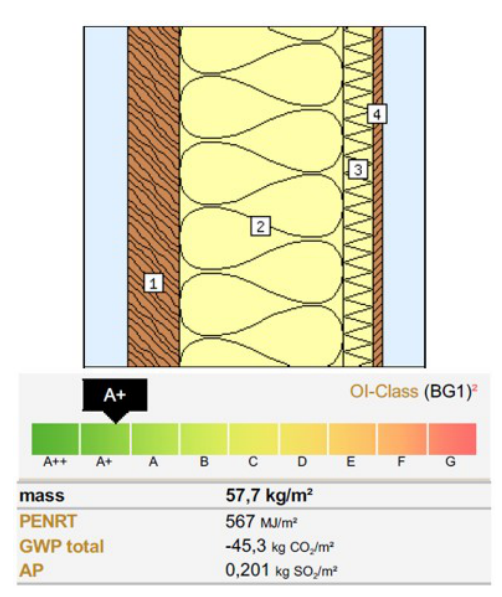
Figure 2. S1 environmental evaluation (baubook.at). Figure 3. S2 environmental evaluation